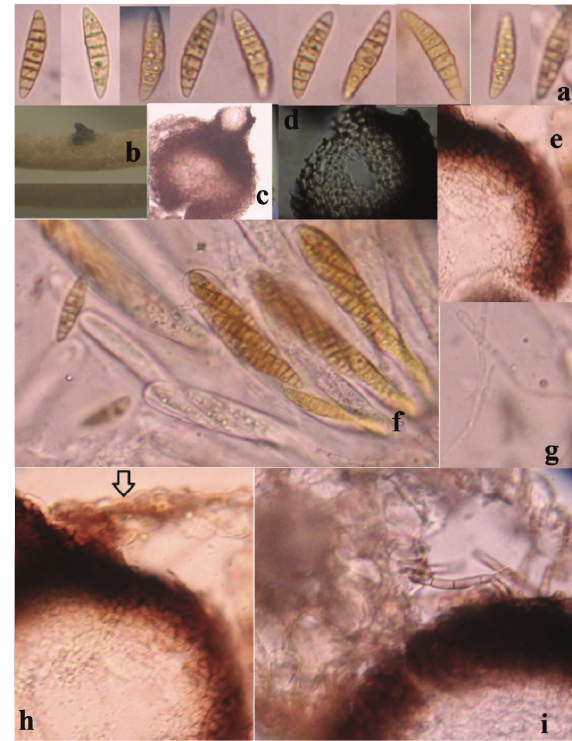
Figure 1 - P. deschampsii : a - ascospores; b - perithecia; c - longitudinal section of perithecia; d - cross section of perithecial neck; e - perithecial wall; f - some mature asci together with some young ones; g - paraphyses; h - perithecial wall and epidermial cells of the host (setae); i- loosely disposed hyphae in the perithecia